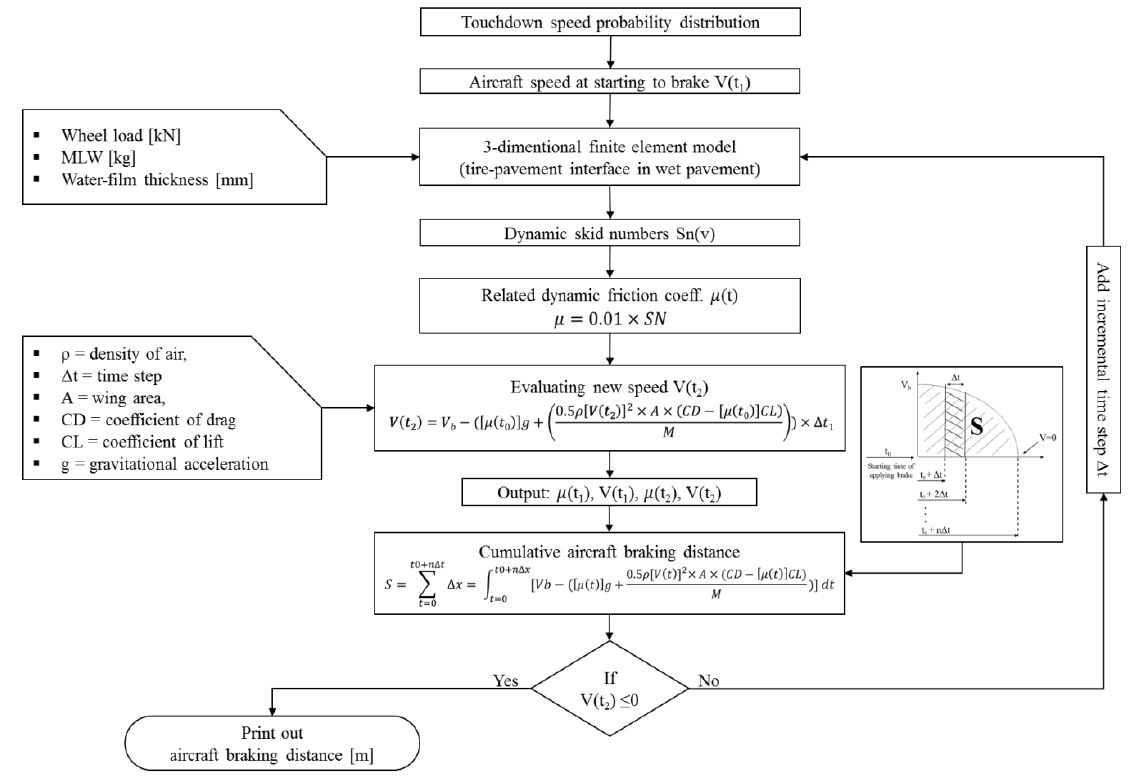
Figure 2. Aircraft braking distance developed algorithm in wet pavement